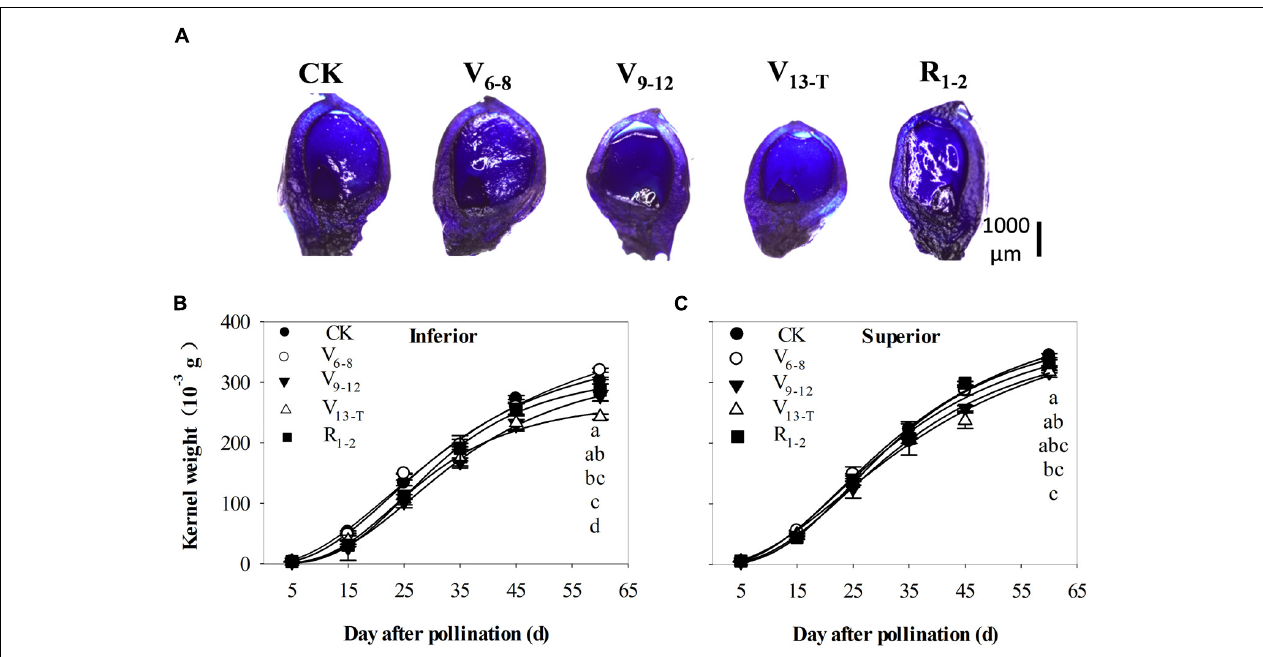
FIGURE 5 | Longitudinal-sectional micrographs (A) of the ovary at 5th kernel ring, stained with toluidine blue at 4 days after pollination, and grain-filling dynamics of inferior (B) and superior (C) kernels in 2015. CK, well-irrigated treatment; V 6 − 8 , water deficit during the 6–8-leaf stage; V 9 − 12 , water deficit during the 9–12-leaf stage; V 13 − T , water deficit from the 13-leaf stage to tasseling stage, R 1 − 2 , water deficit from the silking stage to blister stage. Values with different letters are significantly different at P < 0.05. TABLE 3 | Characteristic parameters of grain-filling curve fitted by using the logistic equation, duration of lag periods (P lag ), active grain-filling period (P active ), maturation drying period